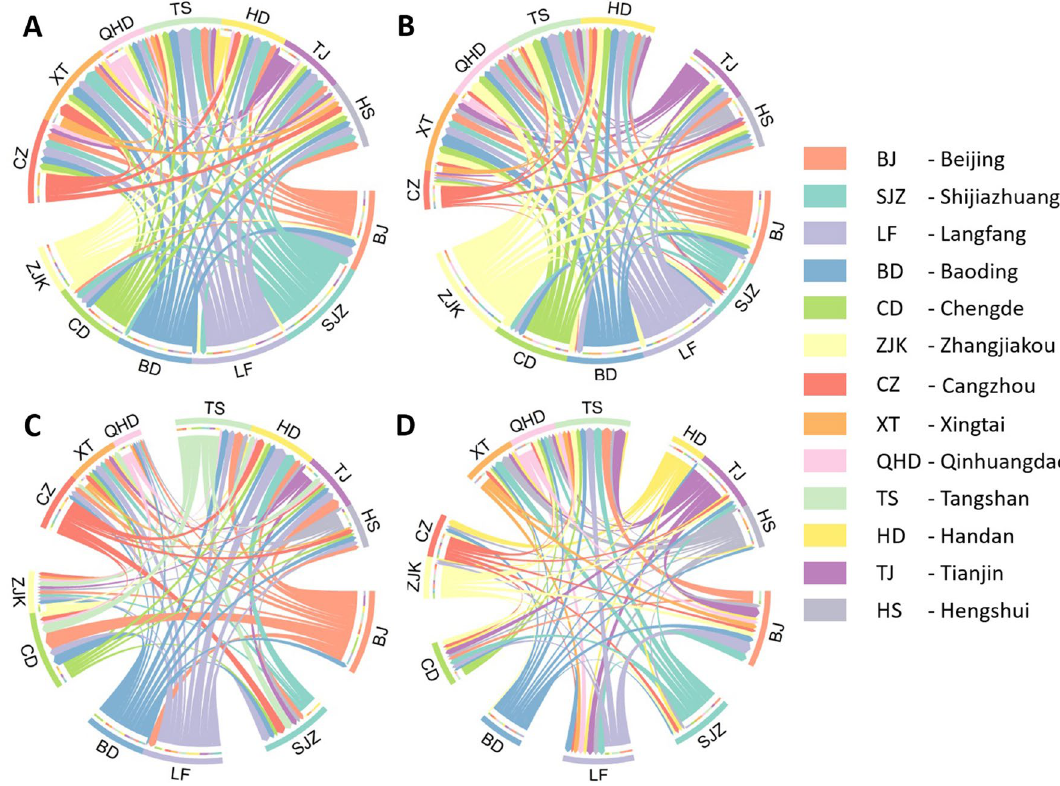
Figure 3. Causal direction among the cities in the Jing-Jin-Ji region. Pollutants are ( A ) CO, ( B ) NO 2 , ( C ) O 3 and ( D ) SO 2 . Gaps are used to roughly distinguish the borders of the pollution impact directions among cities.